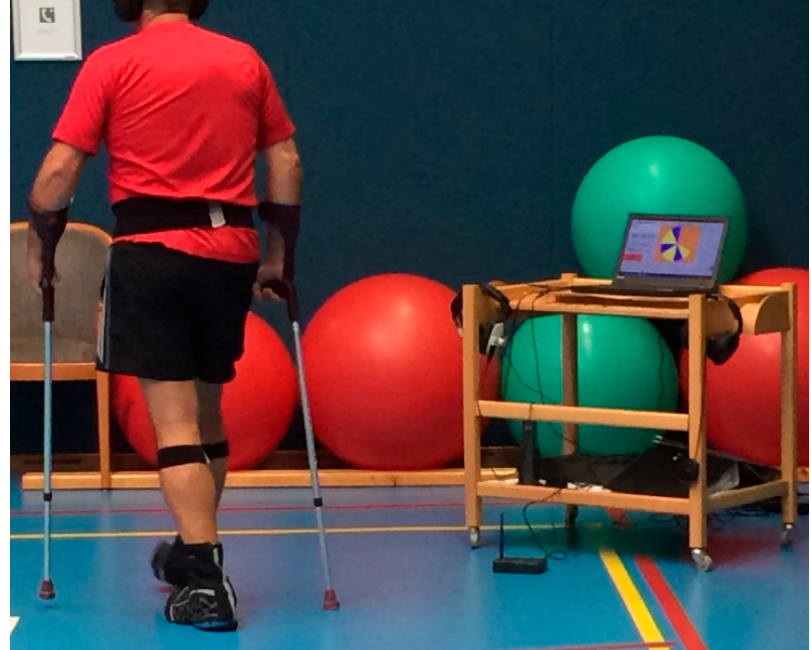
Figure 2. Patient of the sonification group during gait training. The temporal course can be observed on the notebook screen.